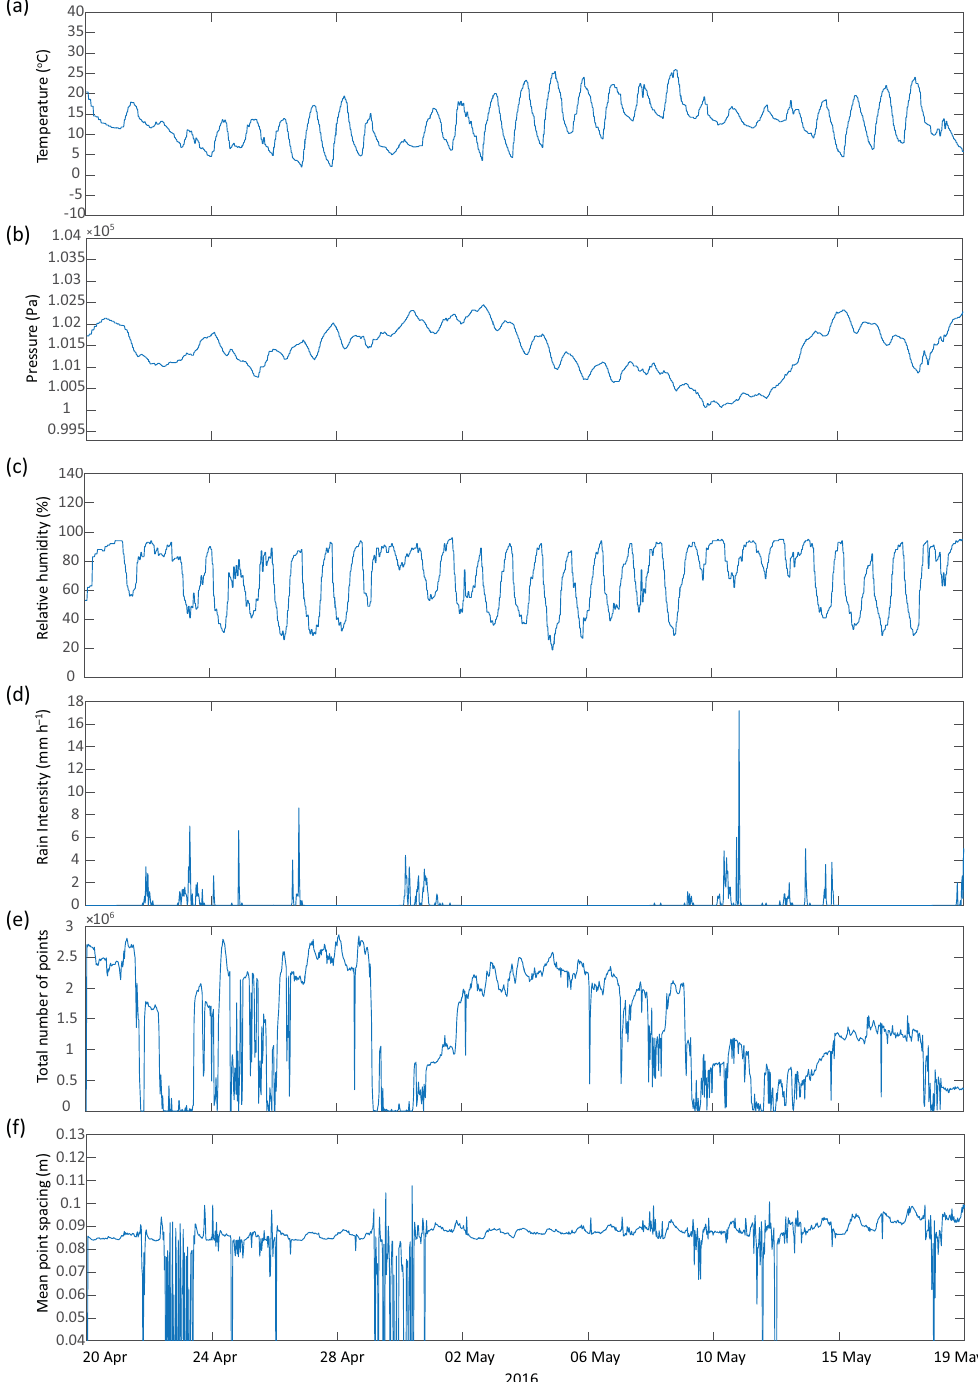
Figure 7. Graphs showing time series of environmental variables and of data quality. Comparison of temperature (a) , pressure (b) , relative humidity (c) , rain intensity (d) , total number of points (e) and mean point spacing of the total number of points (f) from 20 April to 20 May